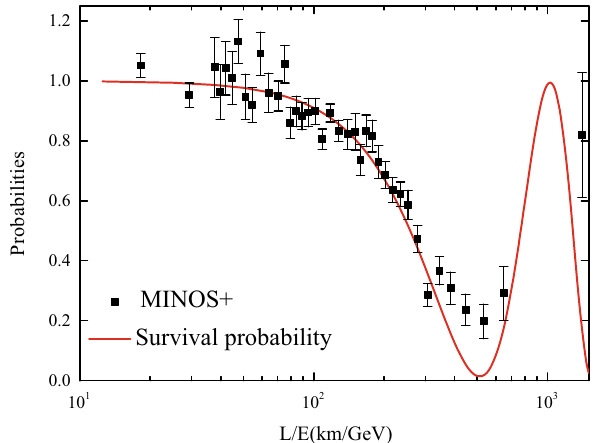
Fig. 4 The survival probability ν μ → ν μ as a function of the distance traveled per energy L / E with an initial muon flavor state. The line denotes the theoretical predictions, and the black squares represent the experiment data from MINOS+ collaboration